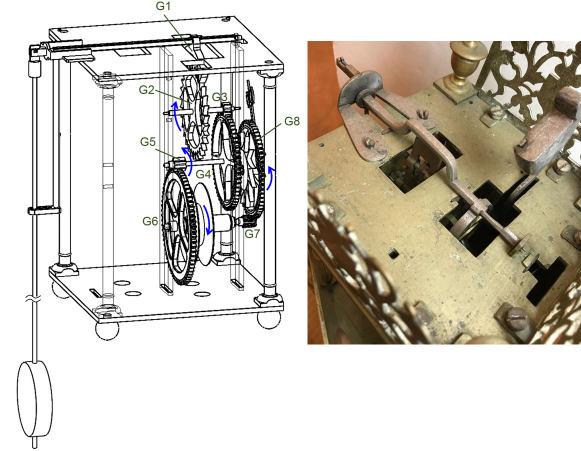
Figure 33. Structure and operation of the N13 going system (Bonhams,